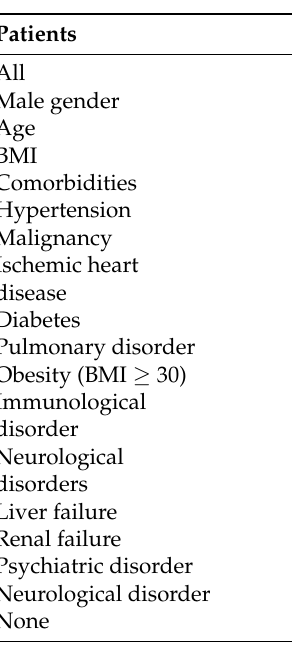
Table 1. Demographics and treatment